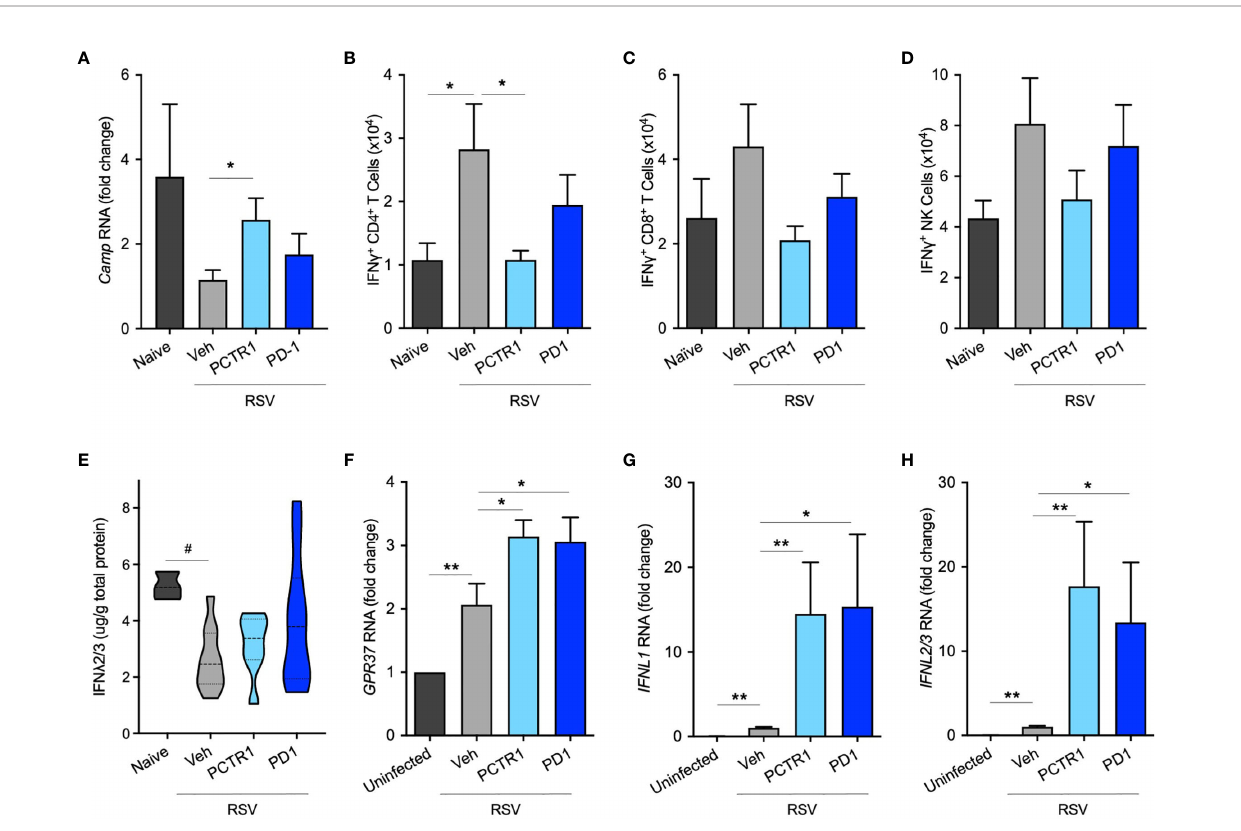
FIGURE 5 | PCTR1 and PD1 regulate host antiviral responses after RSV infection in mice. (A) Cathelicidin Anti-Microbial Peptide ( Camp) RNA expression in mouse lung tissue at day 6 post infection with RSV 10 5 PFU. (B – D) Intracellular IFN g expression in (B) CD4 + T, (C) CD8 + T, and (D) NK cells. (E) IFN l 2/3 protein concentrations in bronchoalveolar lavage fl uid. (F – H) Relative RNA expression of (F) GPR37 , (G) IFNL1 , and (H) IFNL2/3 in human airway epithelial cells. Values are mean of n = 4-11 per RSV group, n = 3-4 per naïve or uninfected group, ± SEM and include ≥ 3 separate experiments (A – E) or 2 separate experiments (F – H) . * p ≤ 0.05, ** p < 0.01 by one- way ANOVA with Holm-Sidak ’ s multiple comparisons correction; # p ≤ 0.05 by Kruskall-Wallis test with Dunn ’ s multiple comparisons